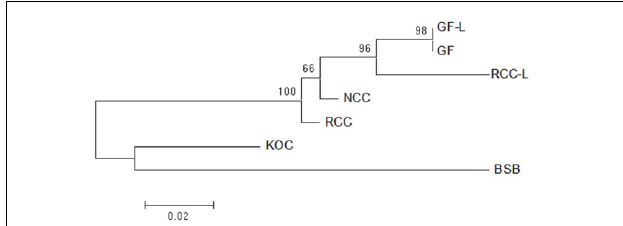
FIGURE 7 | Maximum likelihood tree inferred from 5S rDNA sequences. This tree illustrates the phylogenetic relationships among 5S rDNA sequences in KOC, BSB, RCC-L, NCC, GF-L, RCC, and GF. The numbers at the branch nodes indicate the bootstrap percentage.